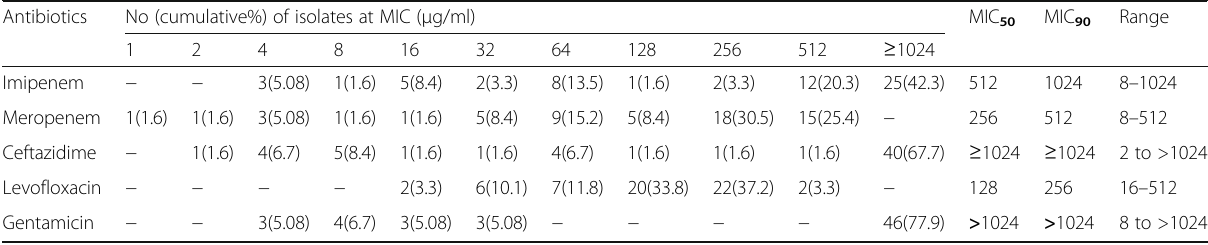
Table 4 MIC distributions for various antibiotics against 59 carbapenem-resistant P. aeruginosa isolates